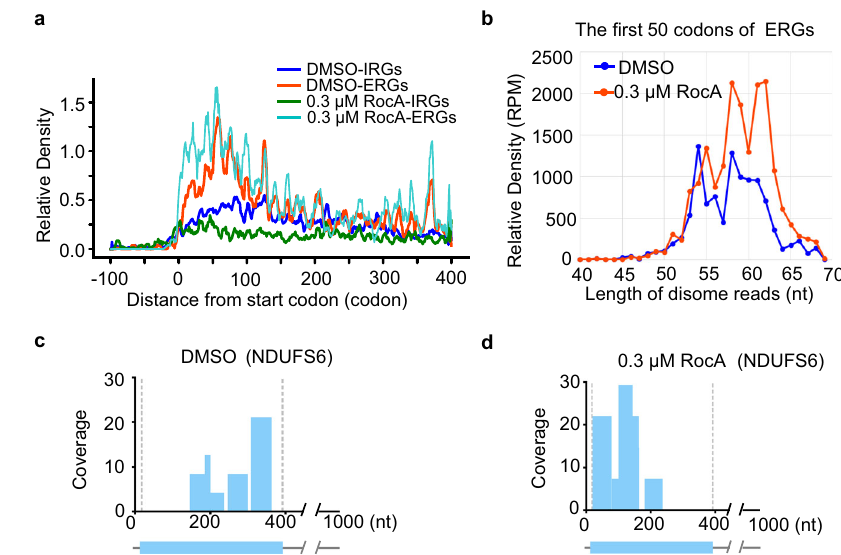
Fig. 2 | Disome-seq reads showing the colliding ribosomes along transcripts upon RocA treatment. a Metagene plot showing the disome distribution of ERGs andIRGs. b Lengthdistributionsofthedisome-seqreadswithinthe fi rst50codons